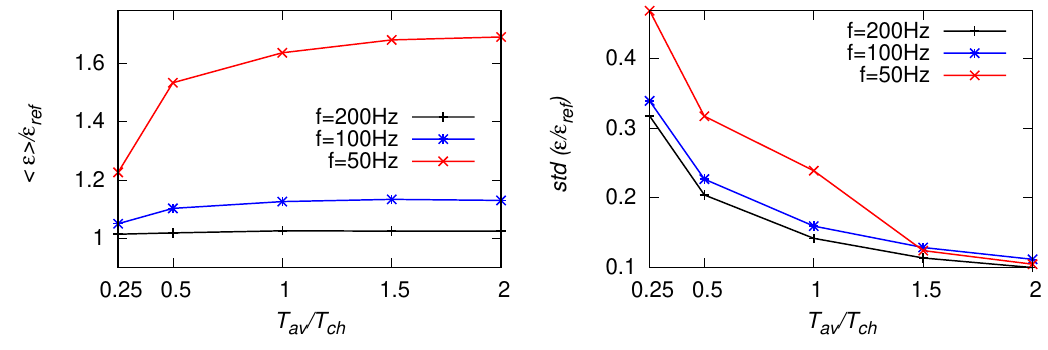
Figure 7. Statistics of (cid:101) PS estimates based on the power spectra, Equation (6), for the fitting range f = [ 10 ÷ 20 ] Hz, from artificial signals with f s = 200 Hz, 100 Hz and 50 Hz. Left panel : EDR averaged along the signal, right panel : standard deviation of the estimates.